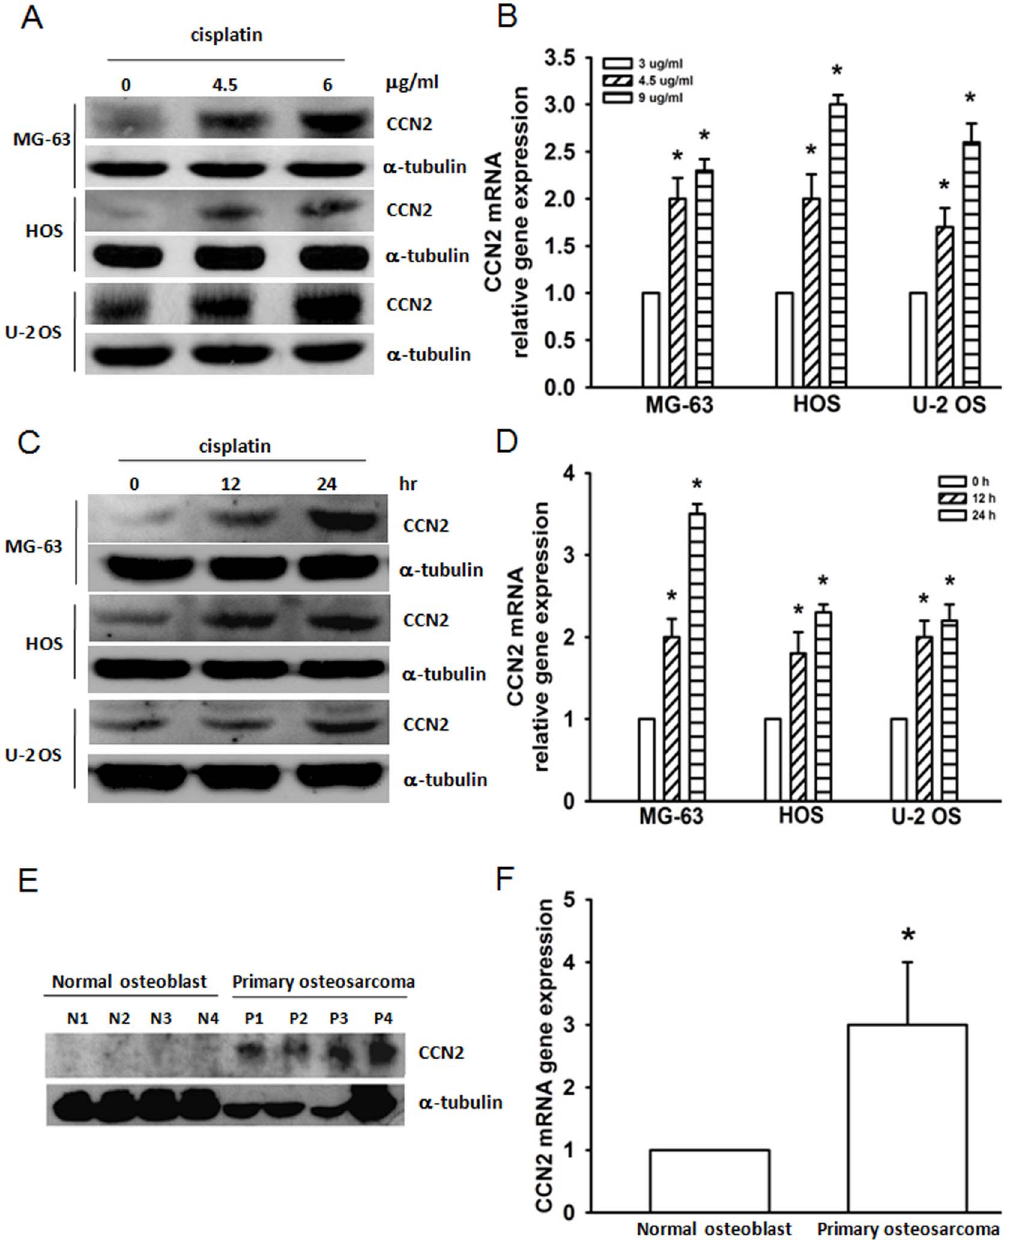
Figure 1. The expression of CCN2 in human osteosarcoma. Cells were treated with cisplatin in different time or dose intervals, and the protein and mRNA expression of CCN2 was examined by western blotting (A & C) and qPCR (B & D). (E & F) The protein and mRNA expression of CCN2 in primary osteoblast cells and osteosarcoma cells were examined by western blotting and qPCR. Results are expressed as mean 6 SEM. *, p , 0.05 as compared with control